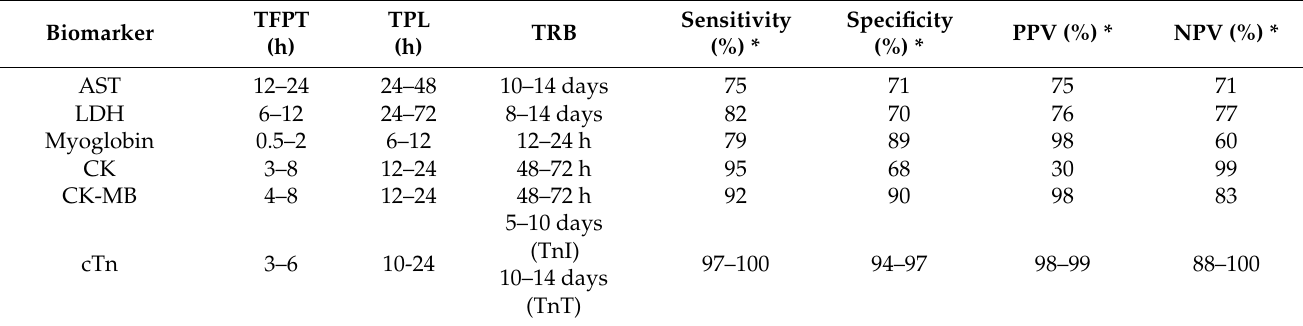
Table 1. Features of historical and current biomarkers used for acute myocardial infarction diagnosis. Biomarker